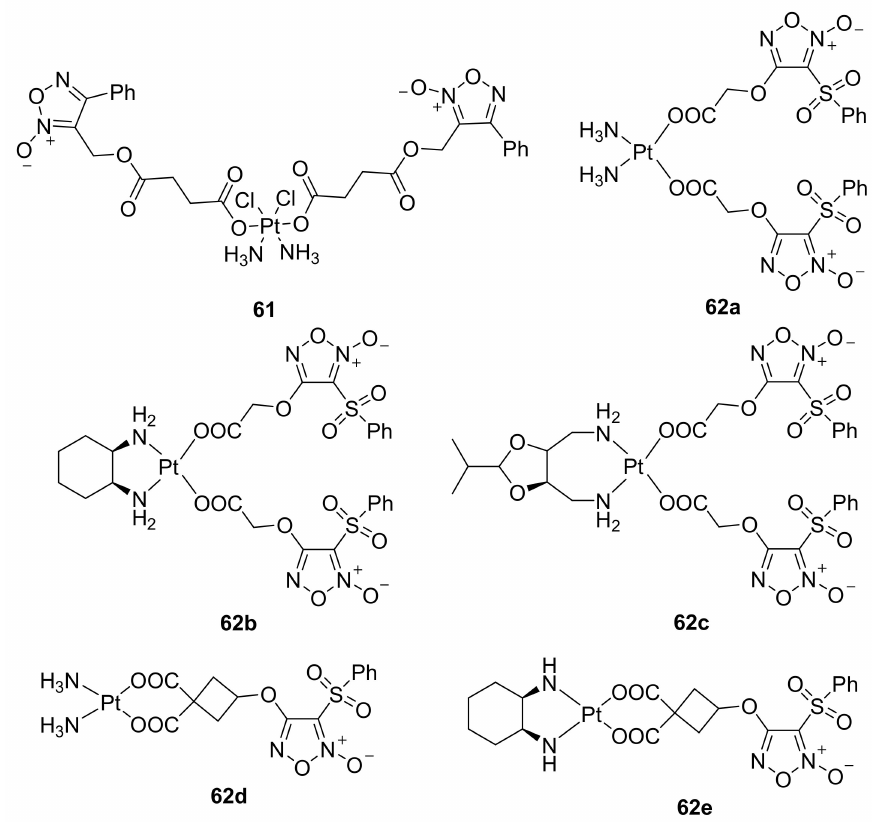
Figure 5. Anticancer furoxan-based Pt-complexes. Hybrid structures 63 and 64 comprising of the furoxan motif and glycolic or acetylsal- icylic (aspirin) acids scaffolds were synthesized (Scheme 32). Both compounds revealed high antiplatelet activity which was comparable to that of the previously investigated CAS 1609. In addition, these structures possess a selective mechanism of inhibition of platelets aggregation mediated by ADP and adrenaline but not ristocetin, collagen and arachidonic acid and their antiplatelet effects are mainly independent of the NO action [106].